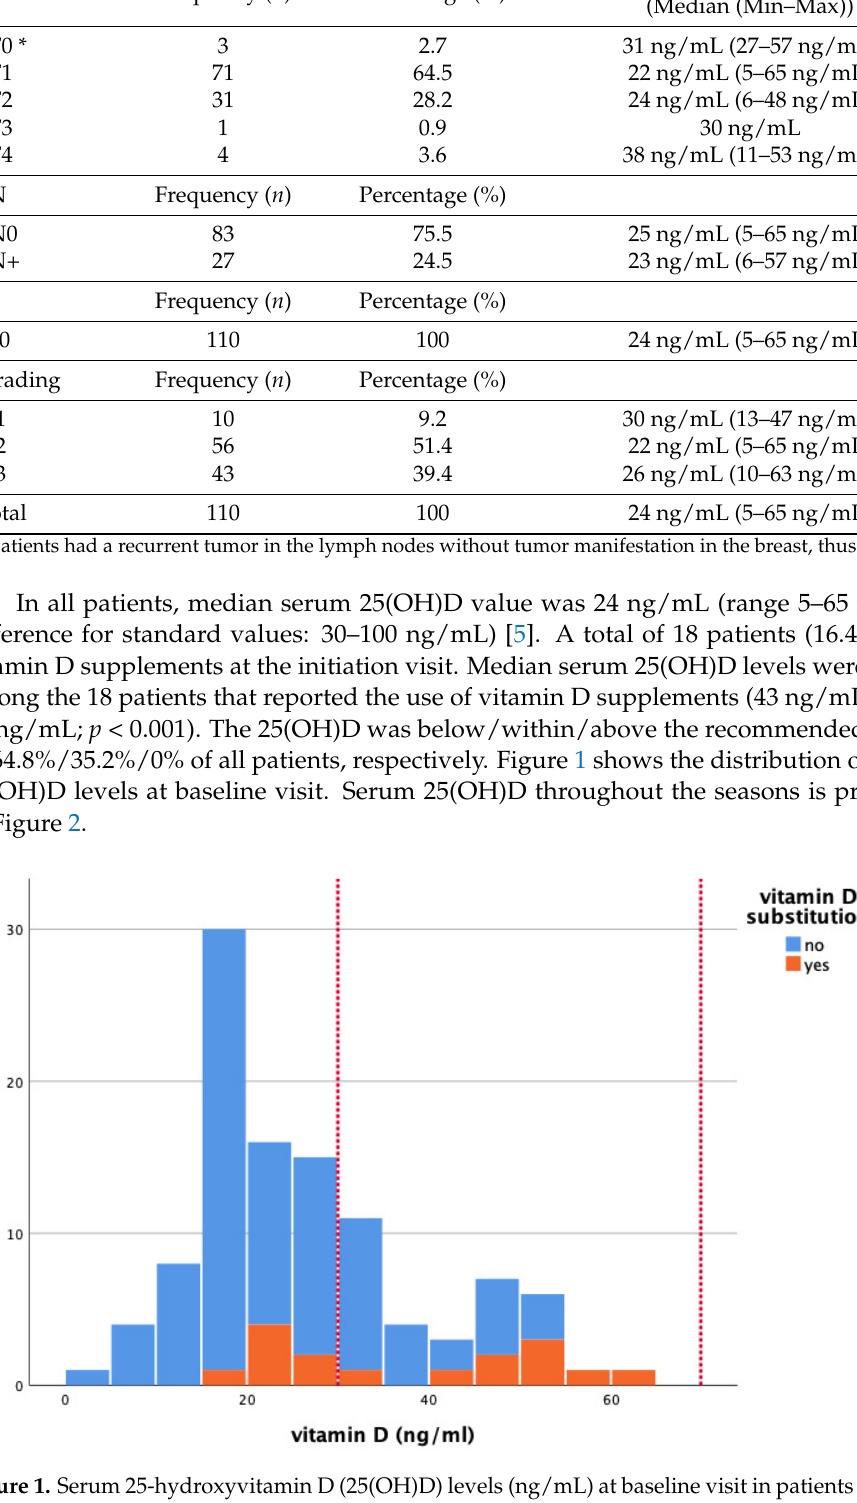
Figure 2. Serum 25-hydroxyvitamin D (25(OH)D) levels throughout the seasons with and without vitamin D substitution. Median vitamin D levels in spring (March, April, May) 20 ng/mL, summer (June, July, August) 31 ng/mL, autumn (September, October, November) 25 ng/mL and winter (De- cember, January, February) 17 ng/mL. (Reference for standard vitamin D values: 30–100 ng/mL).